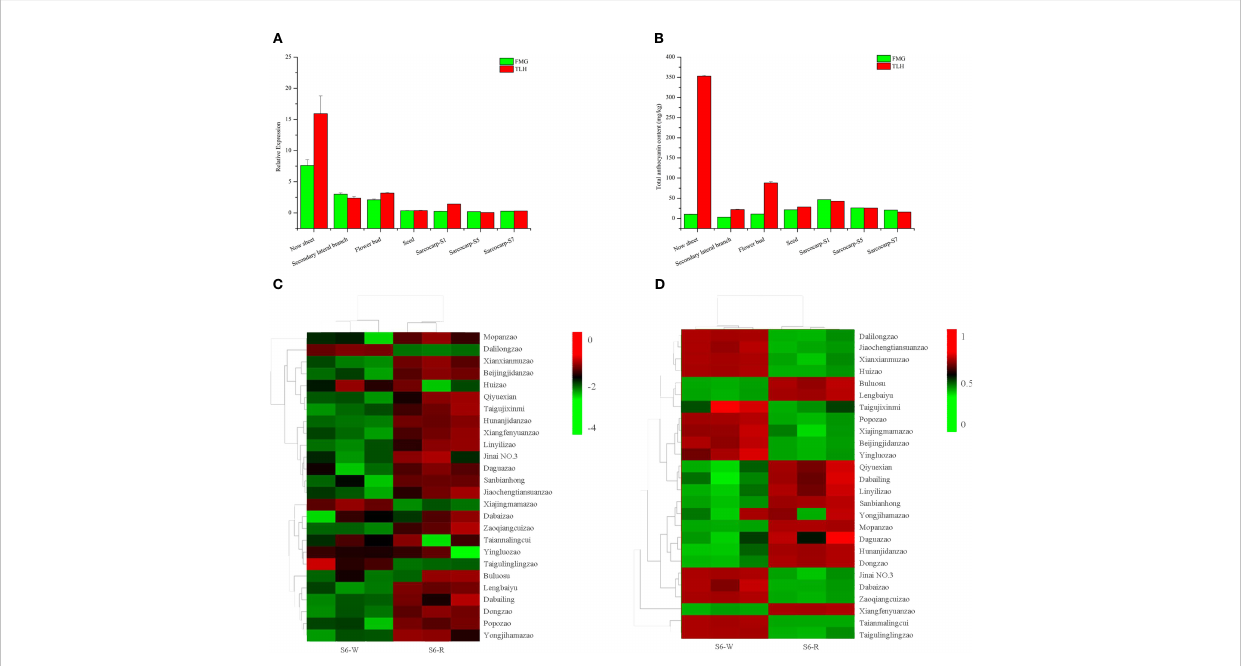
FIGURE 6 Expression patterns of ZjFAS2 . (A) qRT-PCR analysis of ZjFAS2 in Secondary lateral branch, fl ower bud and seed of FMG and TLH. (B) Total anthocyanin content n Secondary lateral branch, fl ower bud and seed of FMG and TLH. (C) Heatmap of ZjFAS2 expression level in S6-W and S6-R from 26 varieties. (D) Heatmap of total anthocyanin content in S6-W and S6-R from 26 varieties. Error bars indicate standard deviations (SDs) from three biological